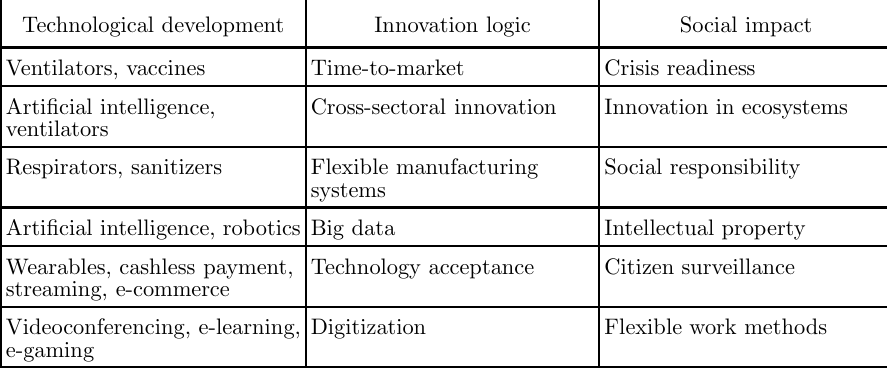
The impact on society of technological developments during the COVID-19 crisis Technological